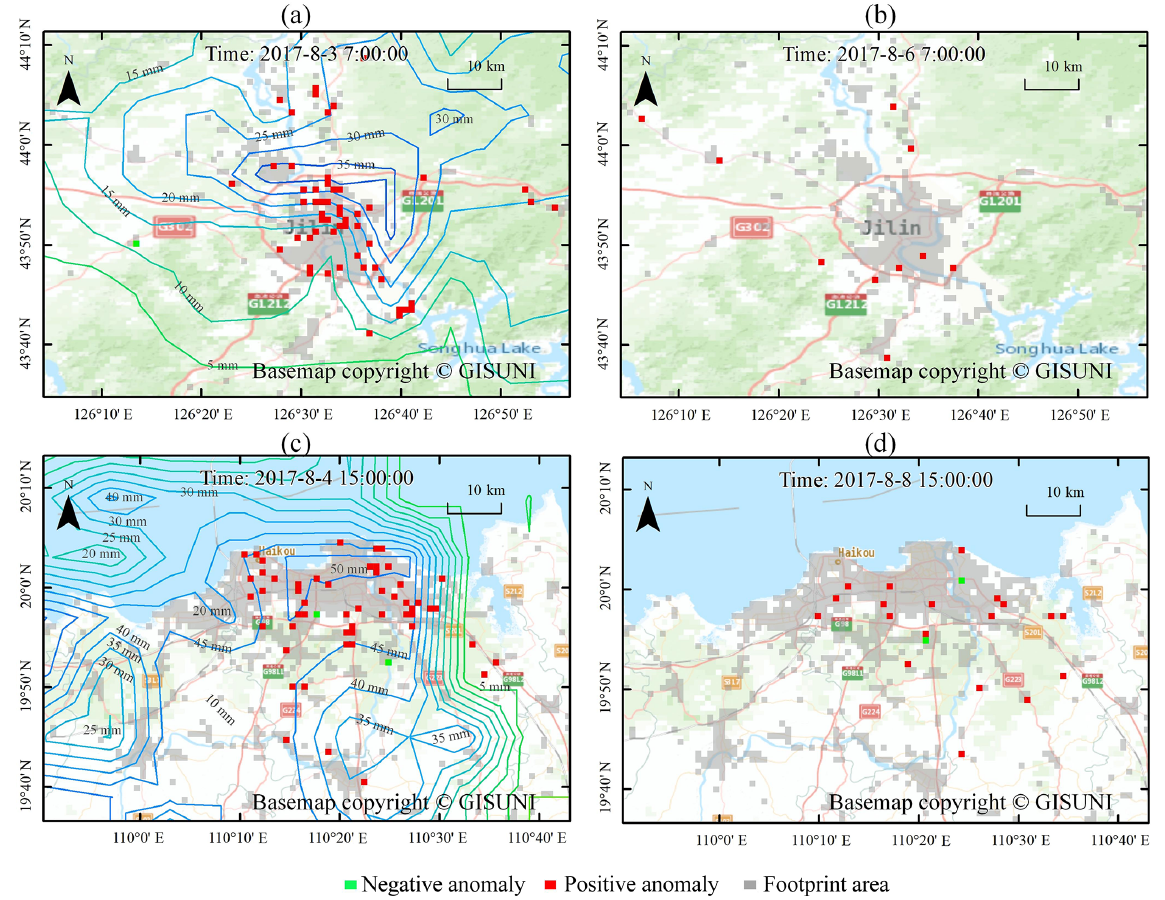
Figure 5. Grid with negative and positive anomalies within the footprint areas of Haikou and Jilin. The contour lines show the precipitation.